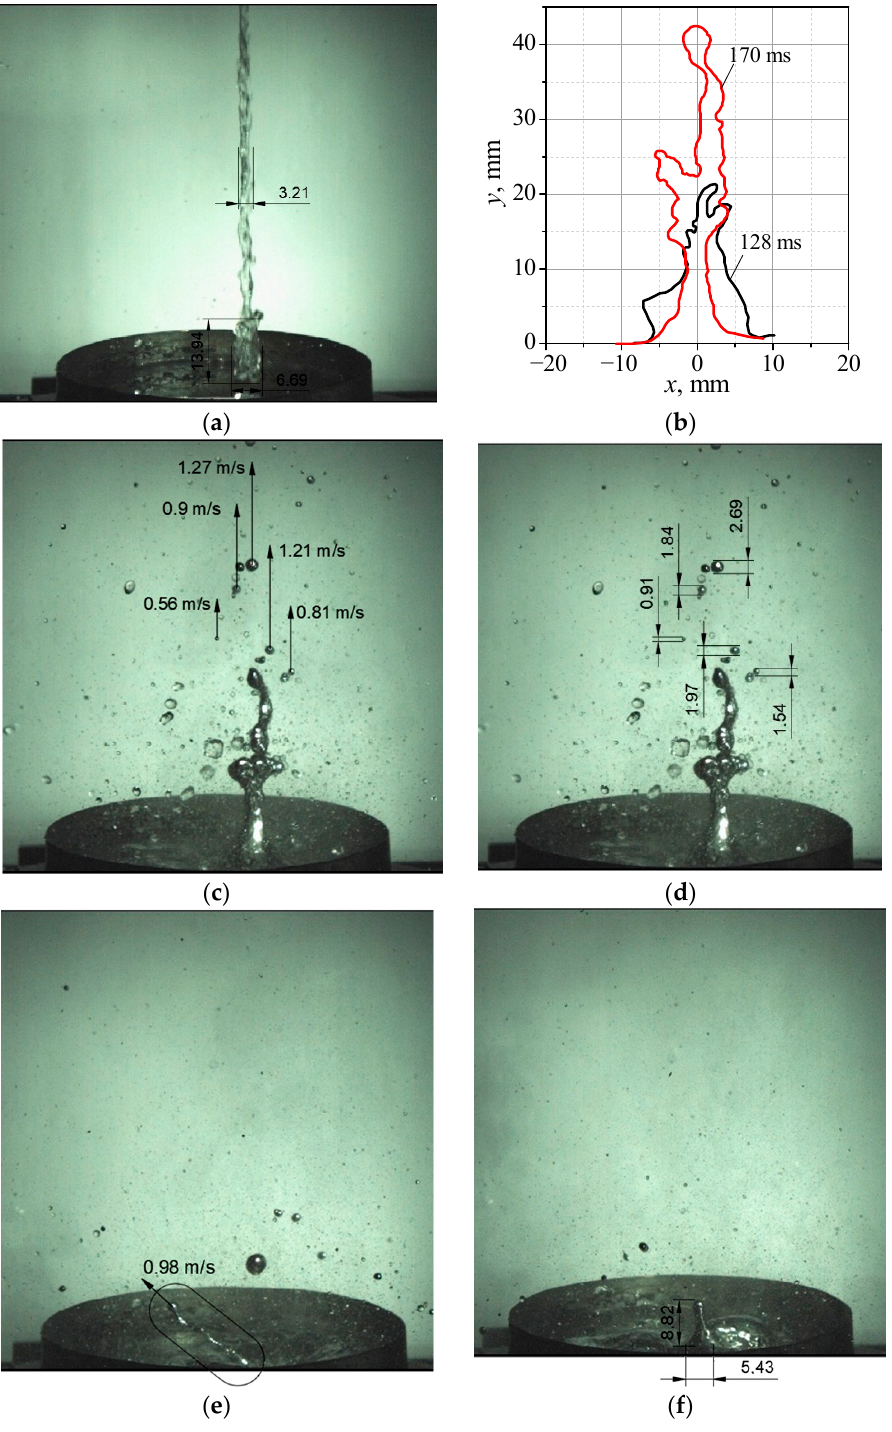
Figure 7. Melt–water jet interaction, Case J3: ( a ) pre-impact shape of water jet; ( b ) shape of the primary cumulative jet at different times; ( c ), ( d ) melt droplets generated with the cumulative jet; ( e ) a streamer with a melt droplet; ( f ) floating bubble on the melt surface with melt streamer. The melt–water interaction in this case was rather intensive, leading to the formation of a cavity, its collapse and the ejection of a thin, tall cumulative jet, see Figure 7b. This